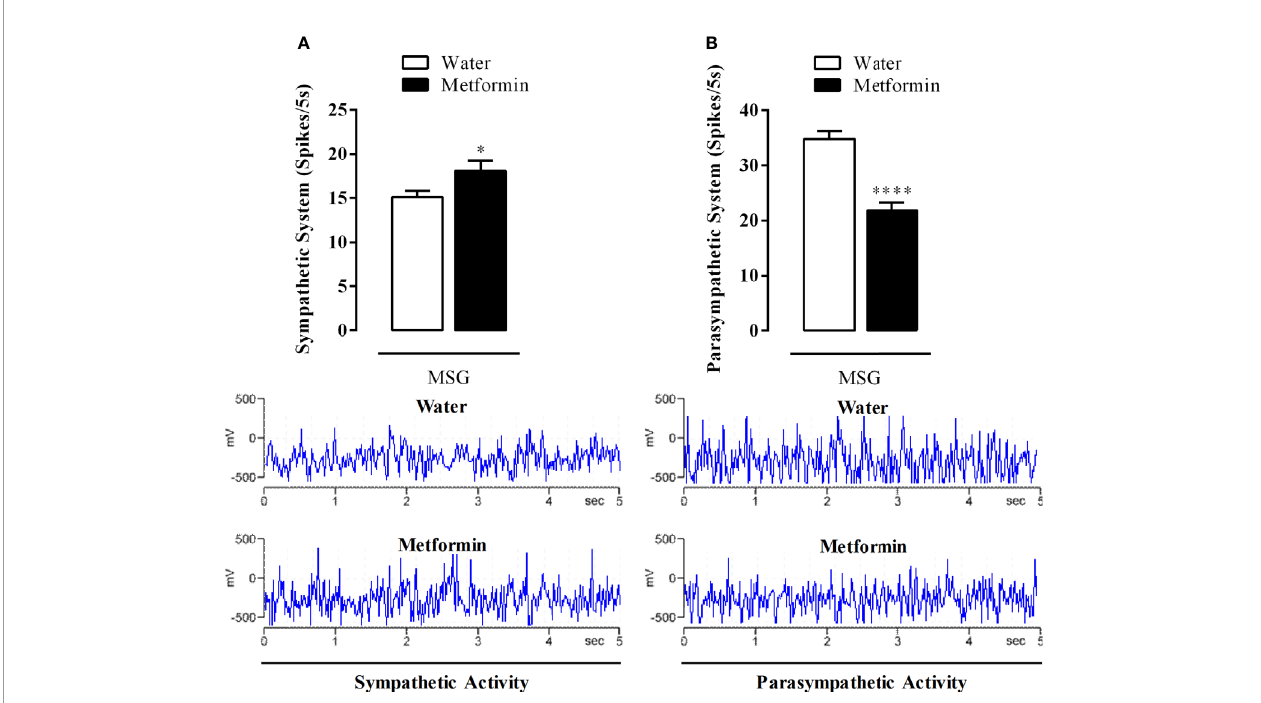
FIGURE 4 | (A) Sympathetic and (B) parasympathetic electrical activity from the cervical superior nerves. The bars represent the mean ± SEM of the fi ring rates from sympathetic nerves and vagus nerves from 12 rats that were obtained from four different litters for each experimental group. Representative records of nerve discharges for each experimental group are in the lower panels. *p <0.02 and ****p <0.0001 by Student ’ s t-test.